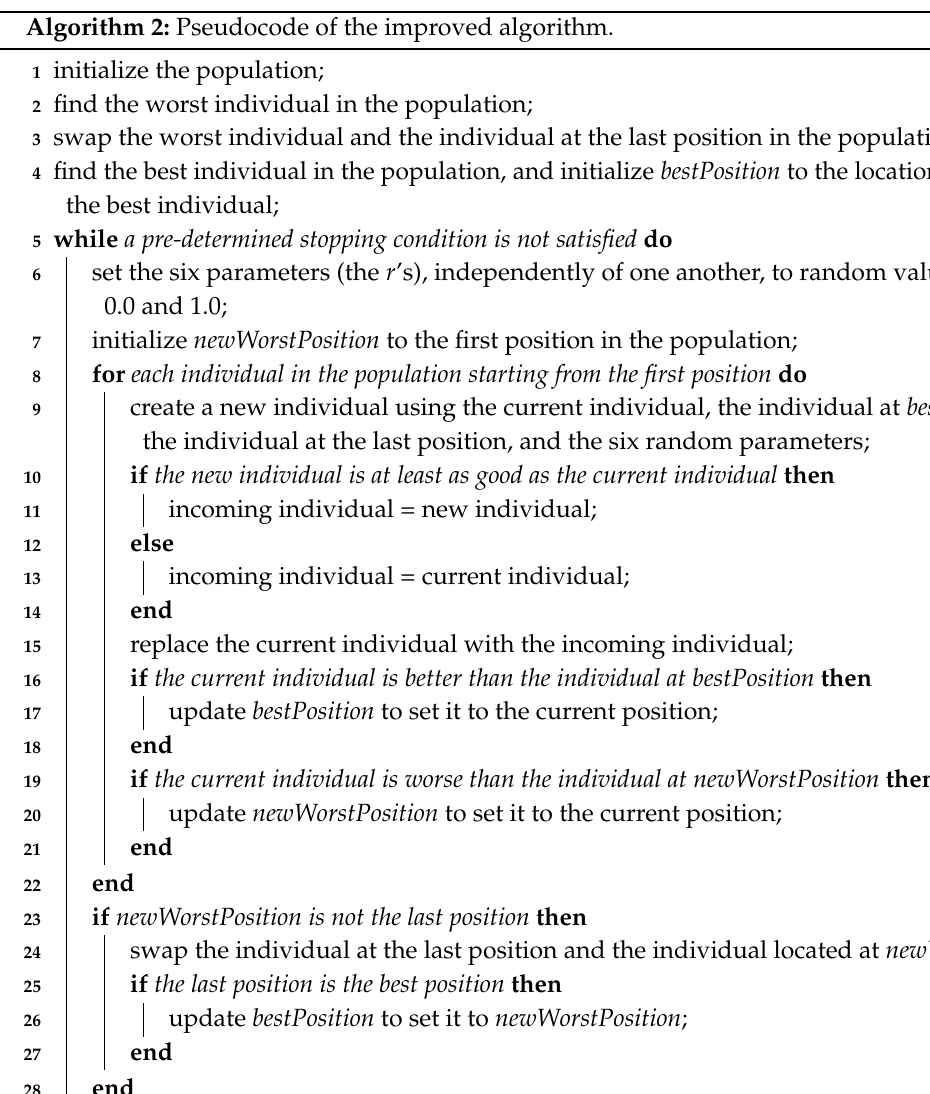
Algorithm 2: Pseudocode of the improved